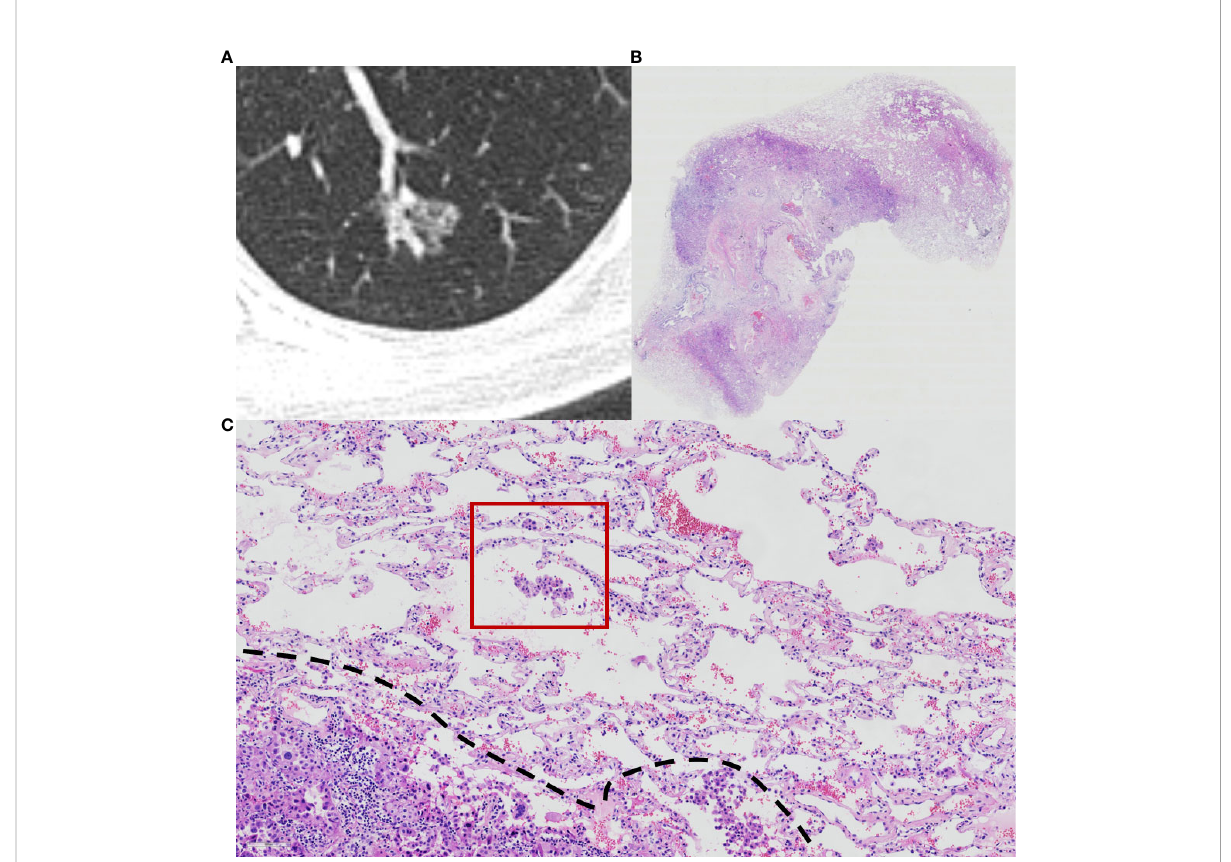
FIGURE 2 Computed tomography (CT) and histology images of spread through air space (STAS)-positive acinar-pattern lung adenocarcinoma. (A) Axial CT image (width, 1,500 HU; level, − 600 HU) shows a partly solid nodule with lobulation and vascular convergence; (B) photomicrograph shows a distinct border between the solid tumor and lung parenchyma (hematoxylin and eosin [HE] stain, ×10); (C) photomicrograph shows detached micropapillary clusters and solid nests of tumor cells in alveolar tissue beyond the edge (dashed line) of the main tumor (HE stain,